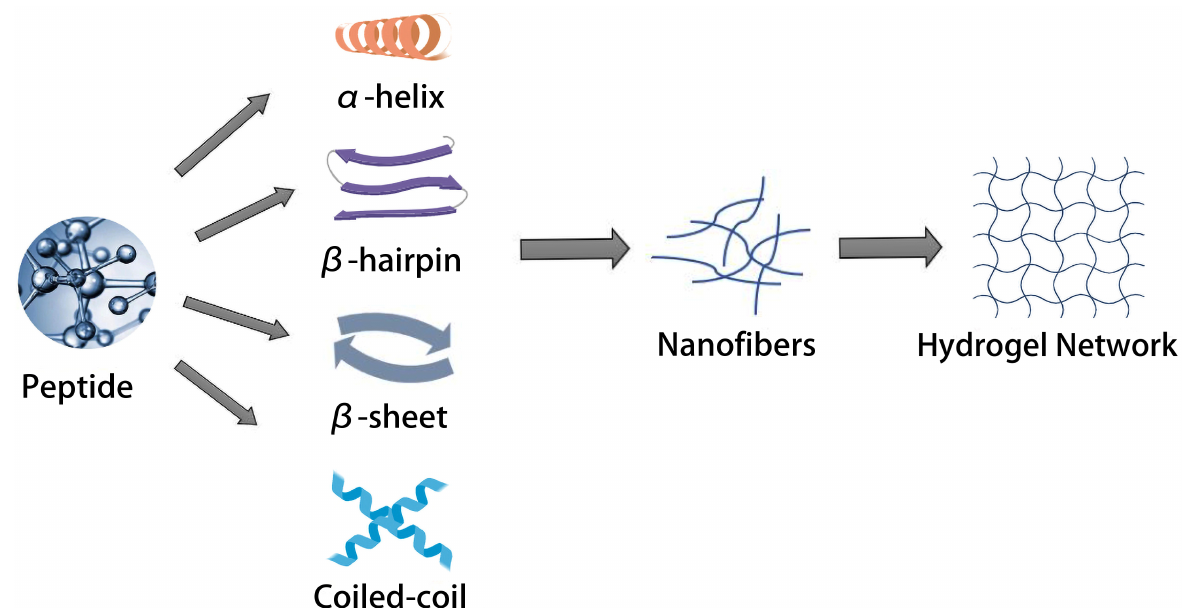
Figure 7. Simplified schematic illustrations of the hierarchical self-assembly process involved in the formation of hydrogels from peptides. formation of hydrogels from